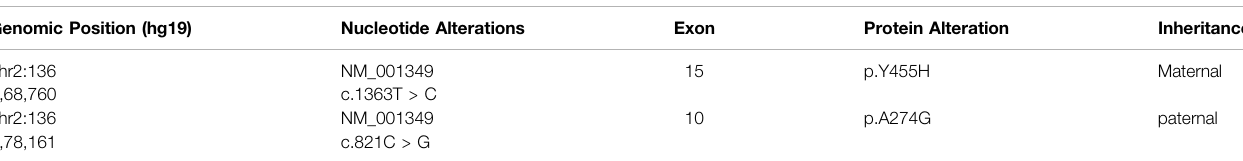
TABLE 1 | DARS Mutations associated of the Patient. Genomic Position